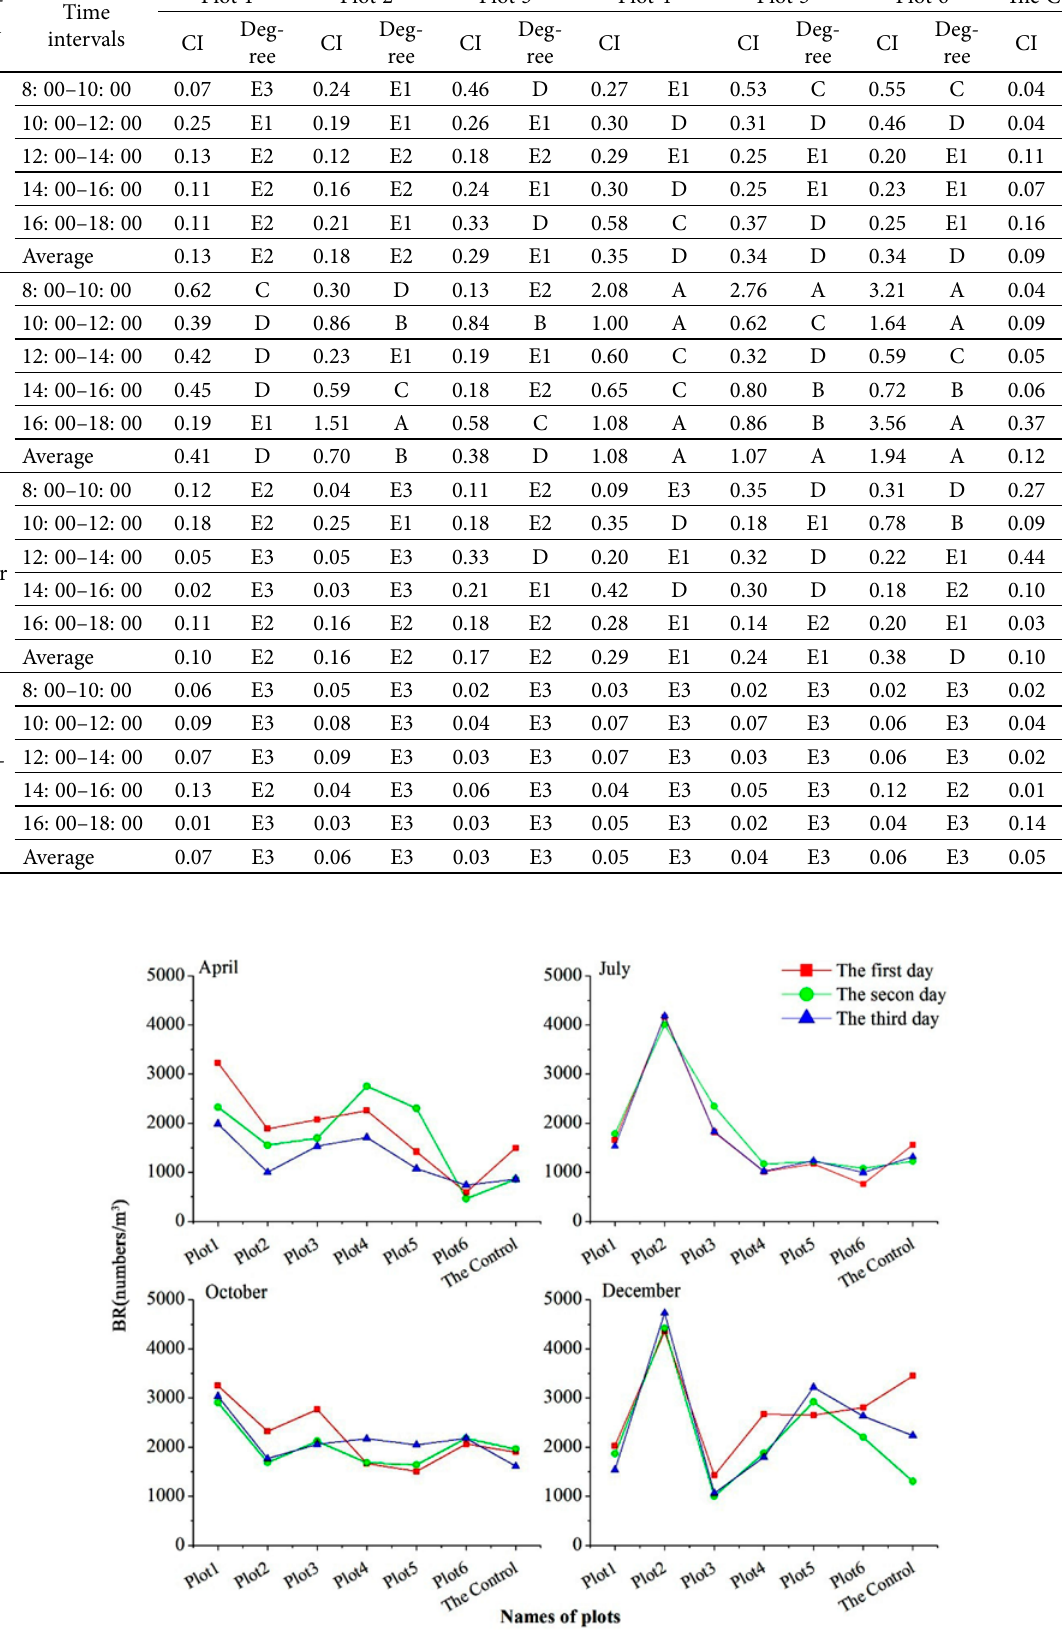
Table 4. Air ion assessment coefficient and air cleanliness class of green belts during seasons Plot 1 Plot 2 Plot 3 Plot 4 Plot 5 Plot 6 The Control Experi- Time mental Deg- Deg- intervals CI CI period